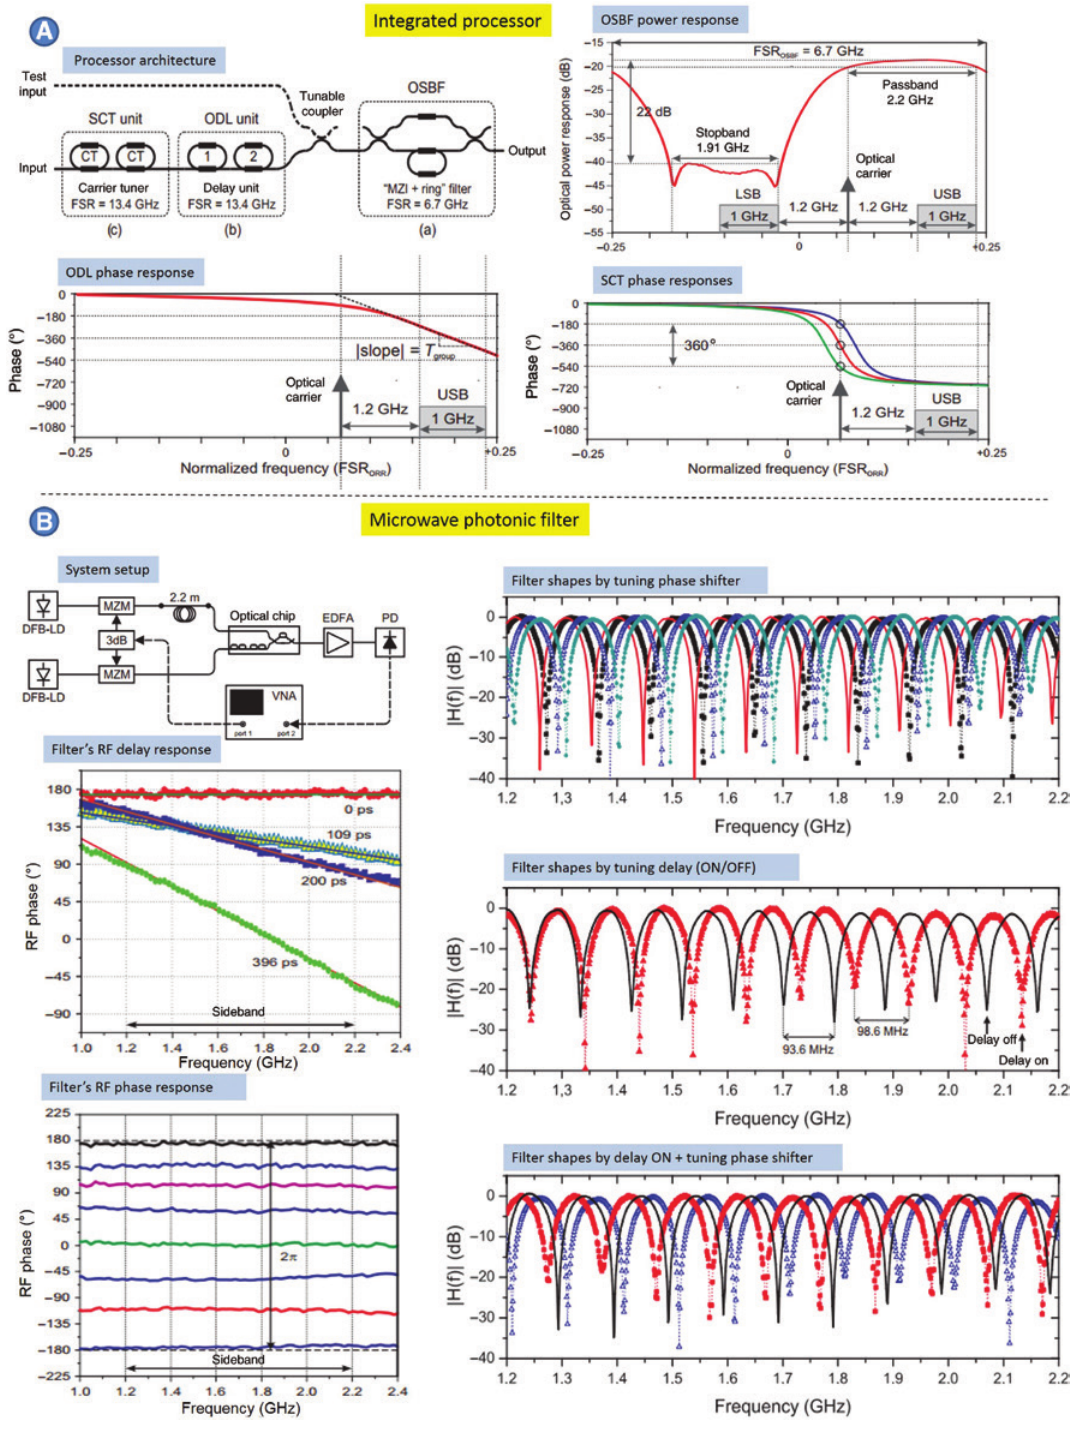
Figure 5: An integrated optical signal processor and a microwave photonic filter. (A) An integrated photonic signal processor design comprising tunable delay lines, separate carrier tuning, and an optical sideband filter. (B) An implementation of a two-tap microwave photonic filter [56] (Copyright in 2011, Optical Society of